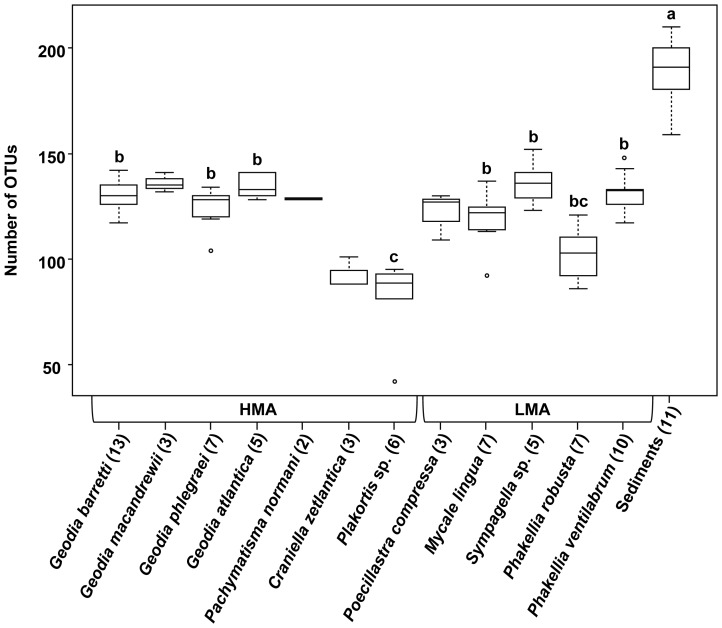
Bacterial OTU numbers.ARISA-derived OTU numbers for all sponge species and ambient sediments are indicated with the number of analyzed samples (i.e. individual sponge specimens) in parentheses. The middle line in each box depicts the median of the respective data set. The box width represents 50% of the data, while both whiskers and outliers indicate the distribution of remaining data points, thus representing the overall variation. Different lower-case letters above boxes denote significant difference in OTU number based on pairwise Kruskal-Wallis rank sum testing at the false detection rate-based adjusted P<0.05 [76]. Species with less 5 specimens were not statistically compared.